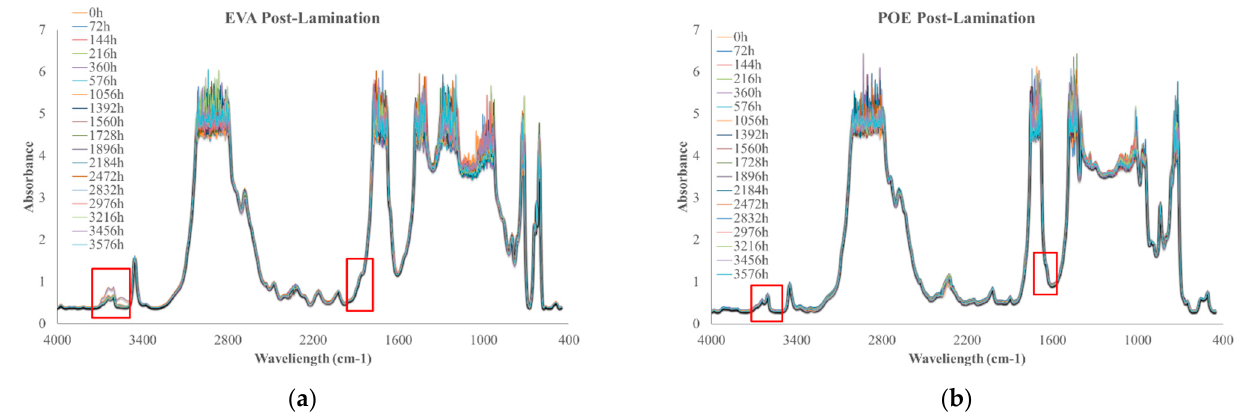
Figure 10. FTIR spectra of ( a ) EVApost-lam and ( b ) POEpost-lam as a function of thermo-oxidation time.